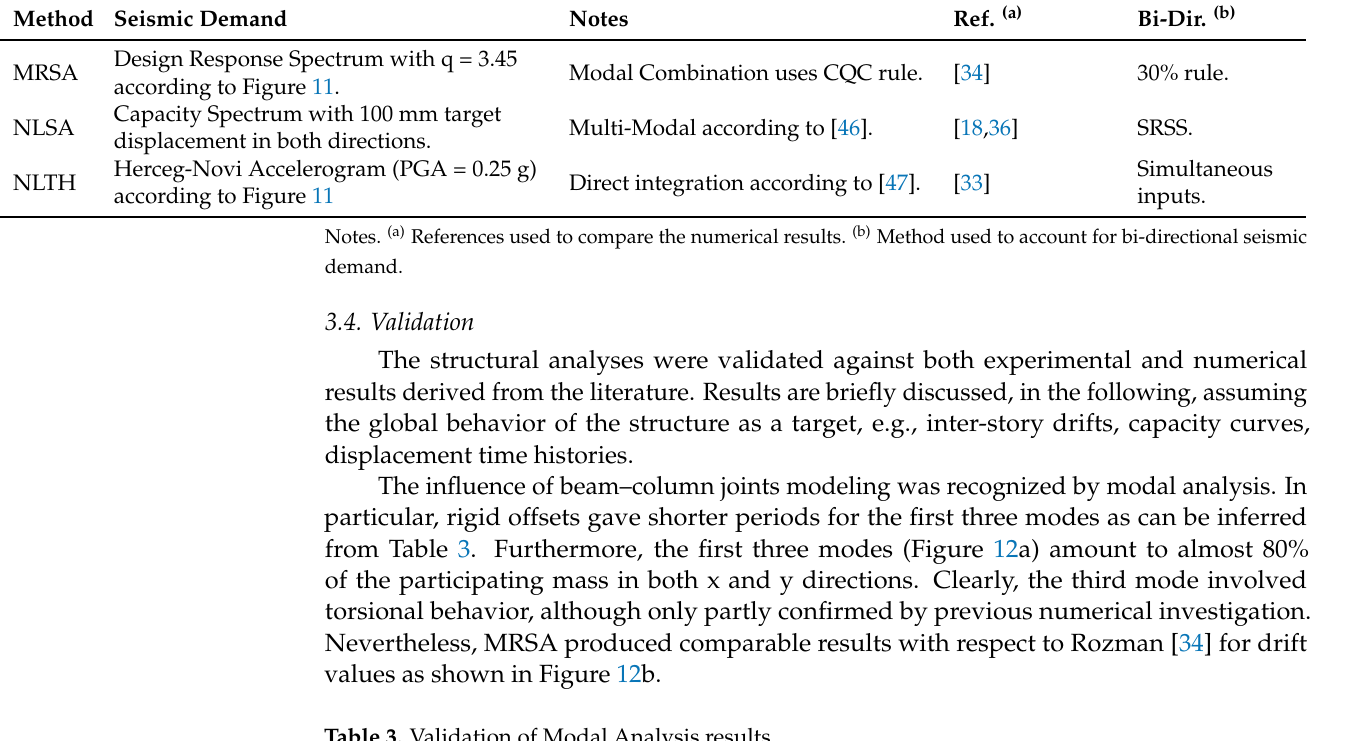
Table 3. Validation of Modal Analysis